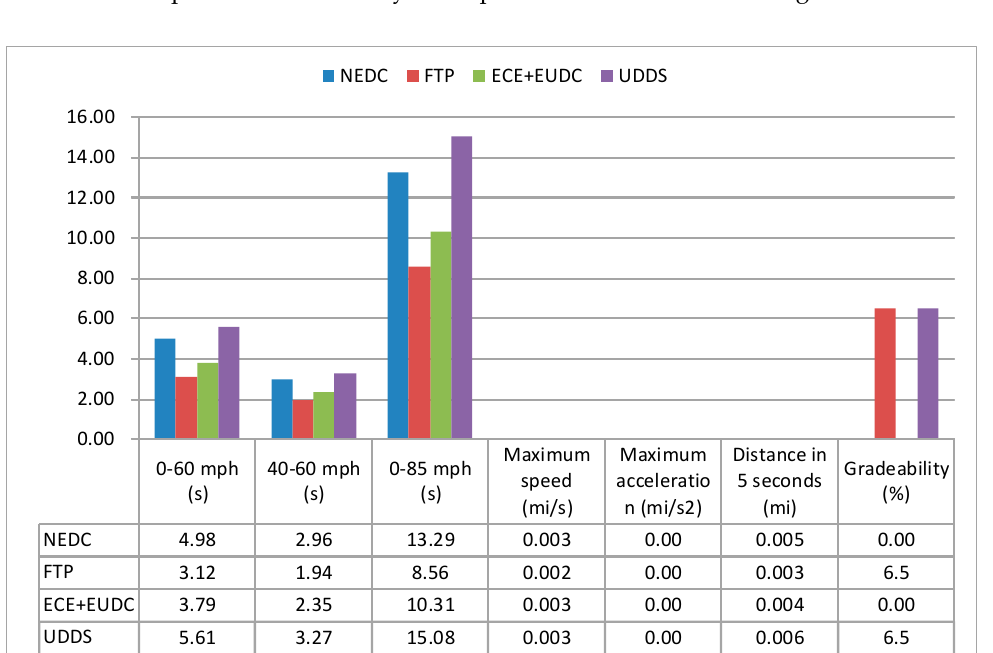
Figure 11. The histogram of the improvements in FC and emissions between the results using initial and optimal values of the parameters of control strategy.